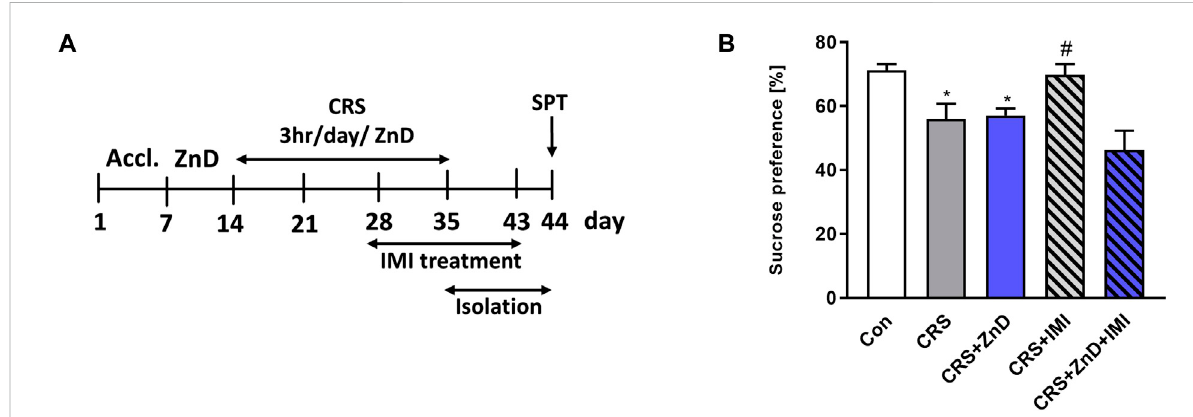
FIGURE 2 Effects ofchronicimipramine treatment intheSPT inmice subjected to CRS and CRS + ZnD. (A) Experimental schedule ofdrug treatmentsand behavioral tests. (B) SPT was performed 24 h after the last treatment. All values are expressed as mean ± SEM. The data were analyzed by one-way ANOVA [F (4, 47) = 7,194; p = 0.0001] and Newman – Keuls multiple comparison test, n = 10 – 11, * p < 0.05 vs. Con; # p < 0.05 vs. CRS. Con: control, CRS: chronic restraint stress, ZnD: zinc de fi cient diet, IMI: imipramine.